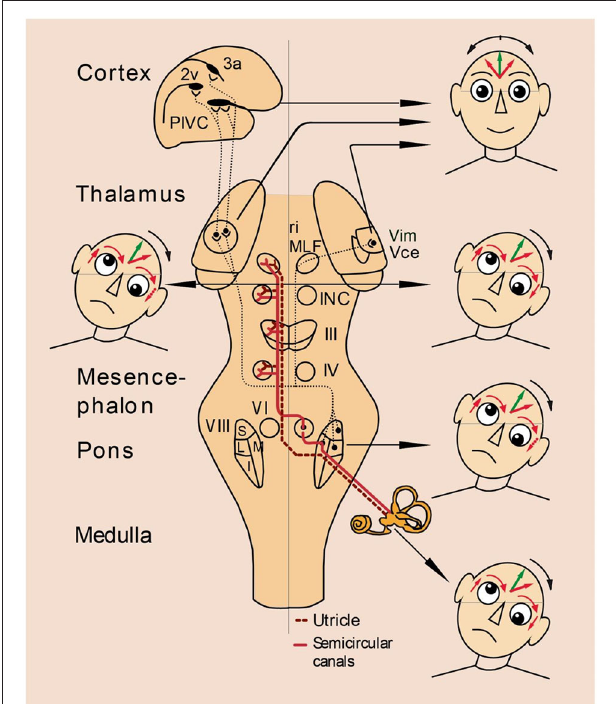
FIGURE 2 | Vestibular syndromes in the roll plane: graviceptive pathways from the otoliths and the vertical semicircular canals mediating vestibular function in the roll plane . The projections from the otoliths and the vertical semicircular canals to the ocular motor nuclei (trochlear nucleus IV, oculomotor nucleus III, abducens nucleus VI), the supranuclear centers of the interstitial nucleus of Cajal (INC), and the rostral interstitial nucleus of the MLF (riMLF) are shown. They subserve the VOR in three planes. The VOR is part of a more complex vestibular reaction, which also involves vestibulospinal connections via the medial and lateral vestibulospinal tracts for head and body posture control. Furthermore, connections to the assumed vestibular cortex (areas 2v and 3a and parieto-insular vestibular cortex, PIVC) via the vestibular nuclei and the thalamus (Vim, Vce) are depicted. Graviceptive vestibular pathways for the roll plane cross at the pontine level. The ocular tilt reaction (OTR; with skew torsion, head tilt, and tilt of perceived vertical) is depicted schematically in relation to the level of the lesion: ipsiversive OTR with peripheral and pontomedullary lesions (bottom two of the heads on the right); contraversive OTR with pontomesencephalic lesions (head on the left). In cases of lesions of the vestibulothalamic tract isolated tilts of SVV may be ipsiversive and in vestibular thalamic lesions, the tilts of SVV may be contraversive or ipsiversive; in vestibular cortex lesions, they are preferably contraversive (top two of the heads on the right). OTR is not induced by supratentorial lesions above the level of